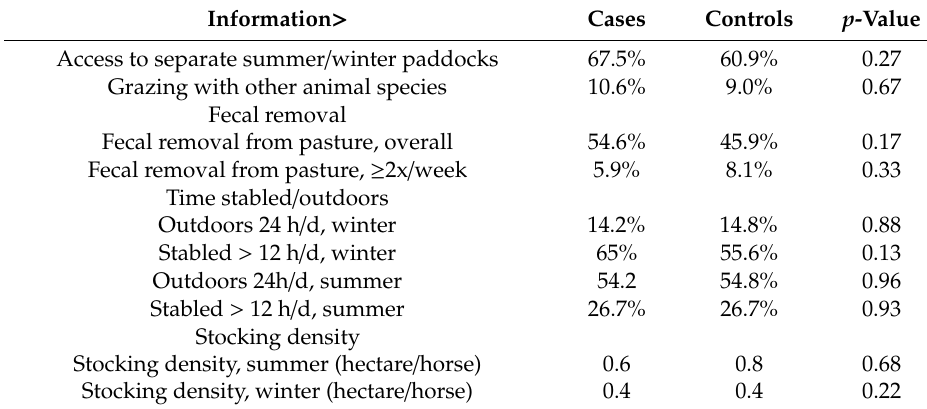
Table 5. Results of questionnaire data: pasture management. The p -value for statistical significance was corrected for the number of analyses (n = 10) according to Bonferroni, i.e., p < 0.005 (0.05 /